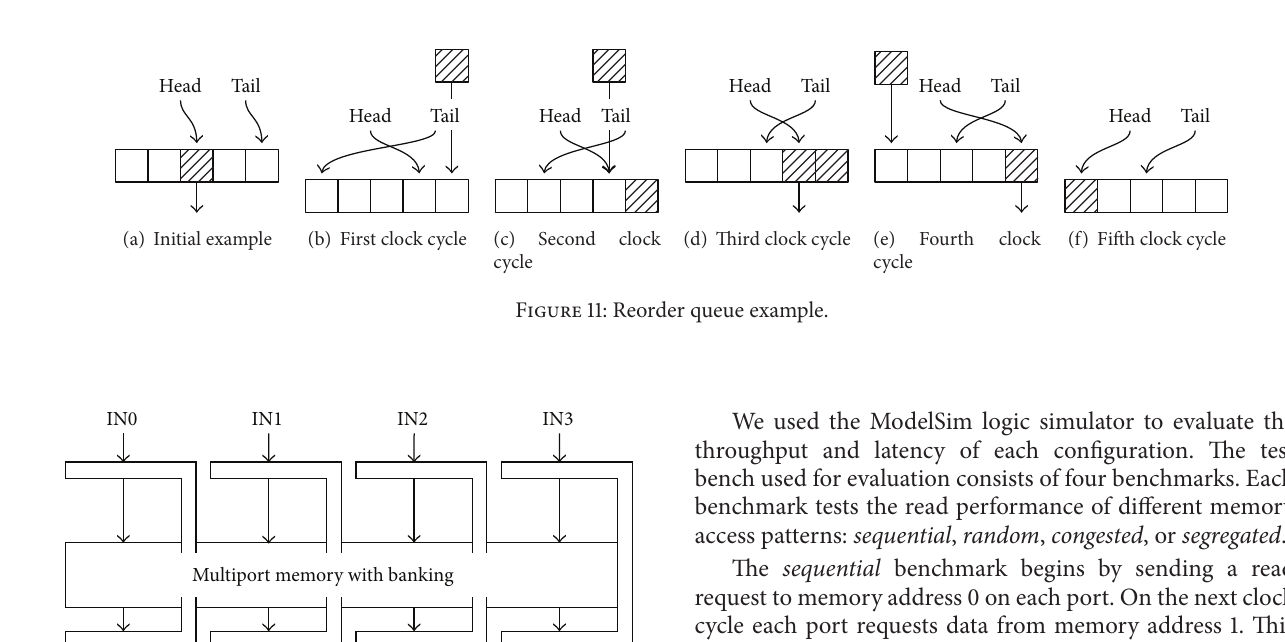
Figure 10: A linked list FIFO during 3 clock cycles of operation.